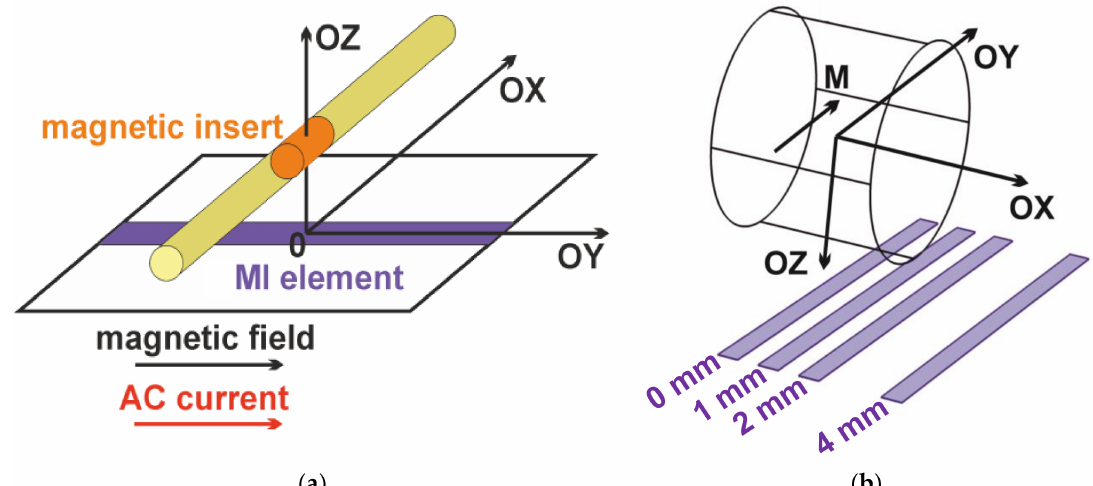
Figure 2. Scheme of the model experiment for detection of magnetic insert mimicking thrombus in the blood vessel by a magnetoimpedance multilayered sensitive element ( a ). Scheme of Comsol modeling of the stray fields of the cylindrical sample of magnetic composite. Positions at the distances of 0, 1, 2, and 4 mm along the OX direction are shown as different rectangular elements for obtaining a visual effect. Magnetization value M = 2.5 G ( b